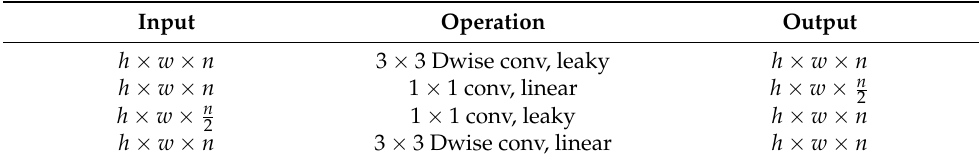
Table 1. The parameters of Sandglass-Residual